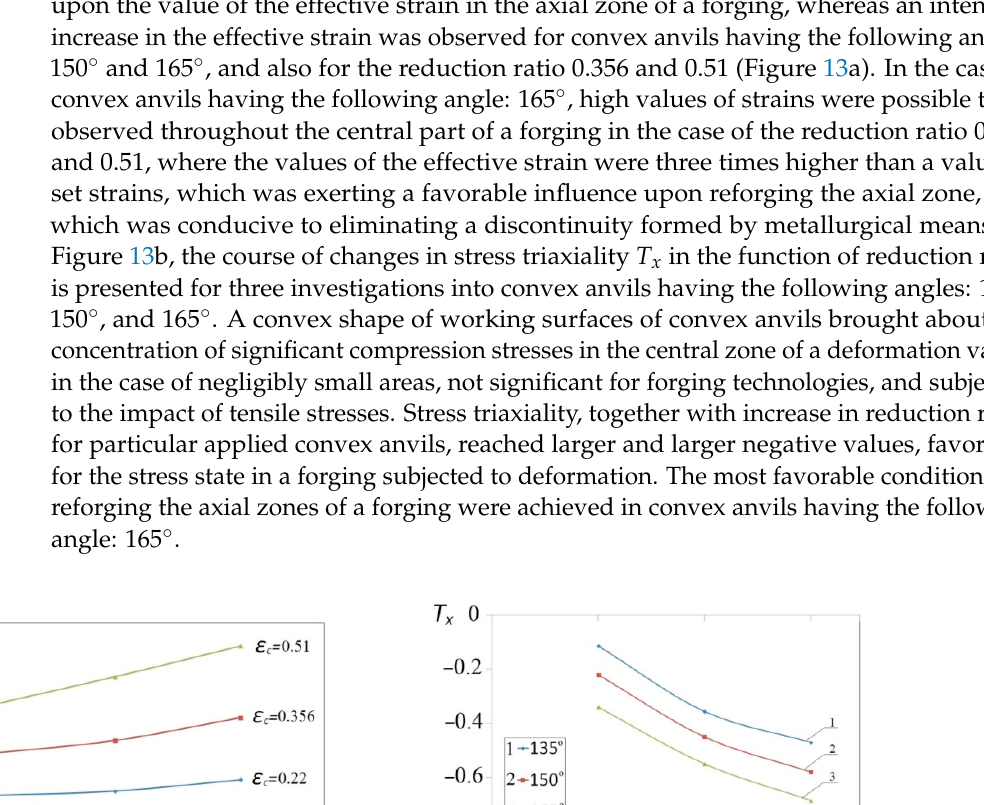
Figure 12. Distribution of the effective strain ( a ), effective stress ( b ), mean stresses ( c ), and temperature ( d ) on the cross- section of the workpiece in the course of forging in convex anvils after the second pass ( α c = 165°, ε c = 0.51).